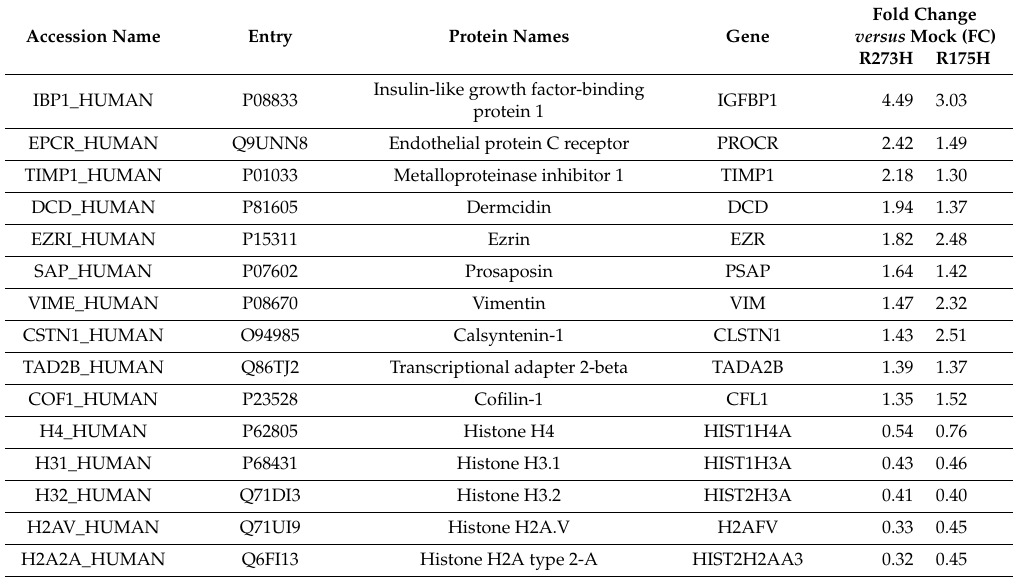
Table 1. Fifteen common secreted proteins by both R273H or R175H mutant p53 isoforms expressed